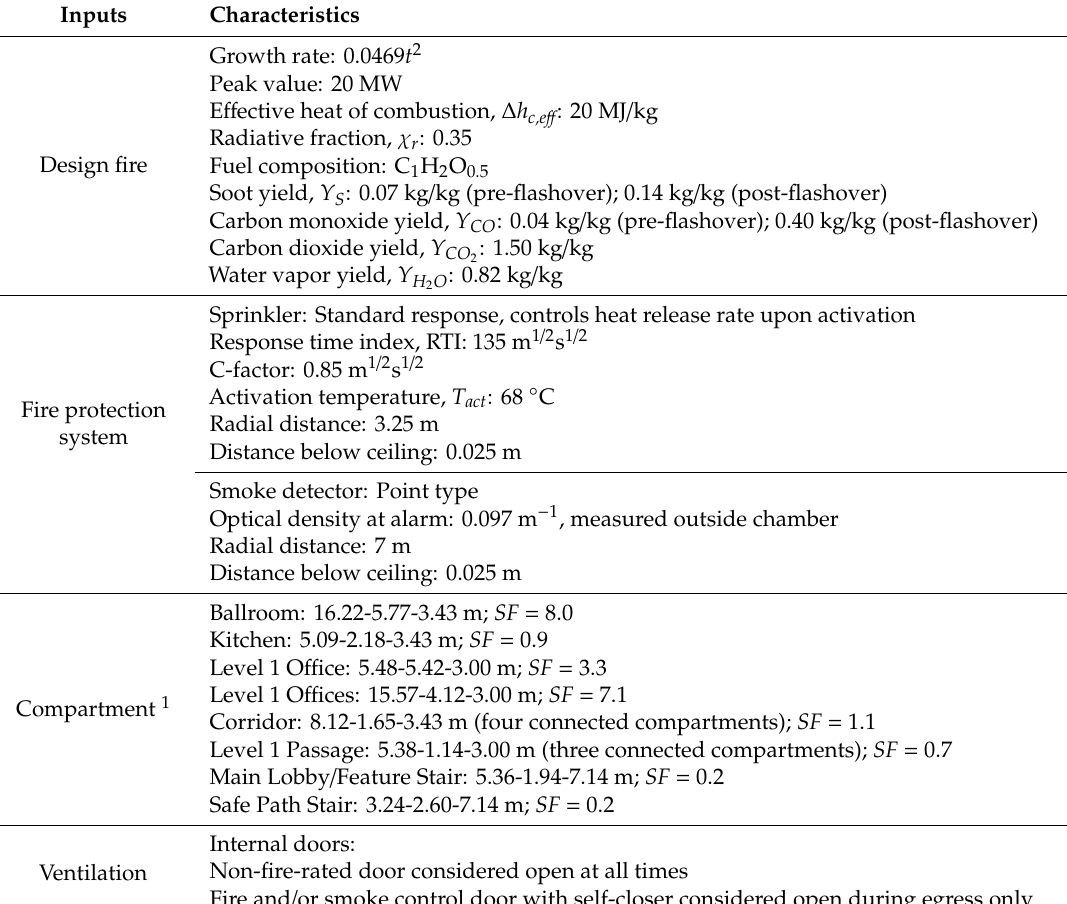
Table 2. Characteristics of the design fire, fire protection system, compartment and ventilation for simulating design fires of Design Scenario